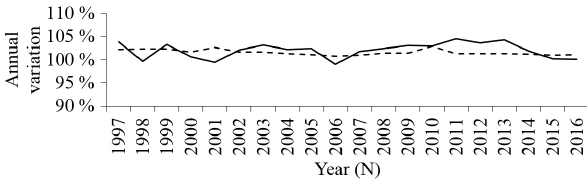
Figure 3. Comparison between the annual variations in the number of fire insurance policies for the residential line of business (solid line) and the California population (dashed